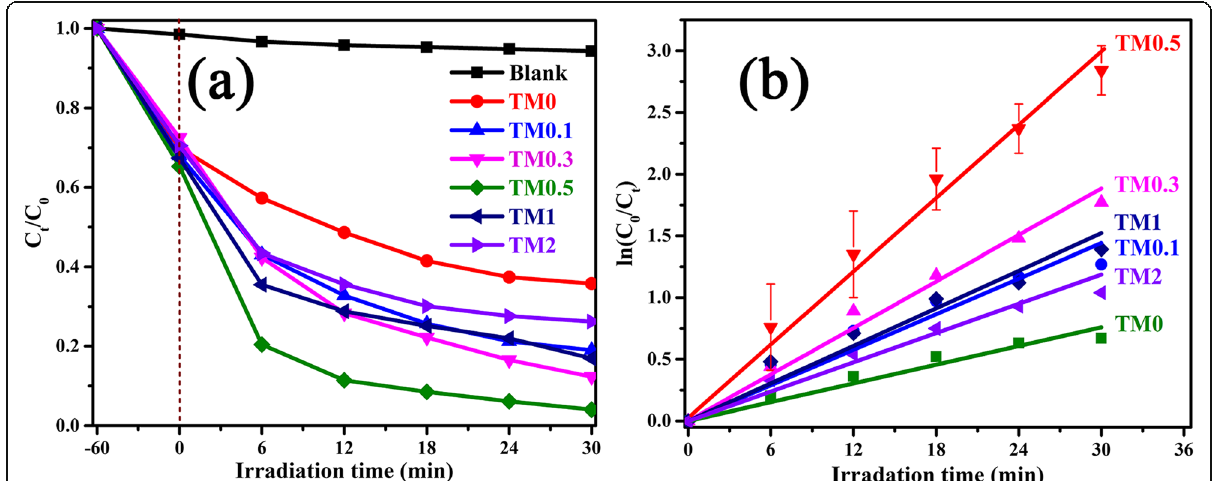
Fig. 6 a Photocatalytic degradation performance. b The corresponding rate constant k values of TM0, TM0.1, TM0.3, TM0.5, TM1 and TM2 composites under visible irradiation (30 mg/L MO